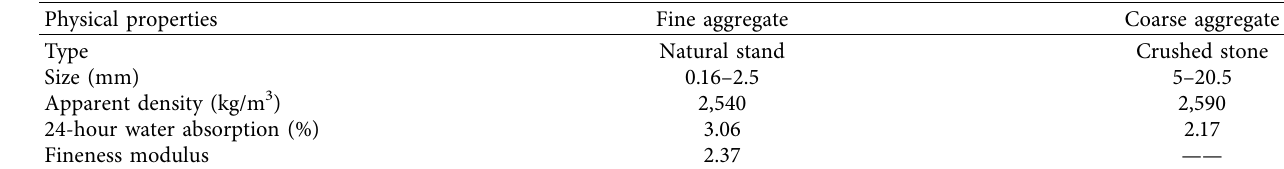
Table 3: Physical properties of the aggregates.